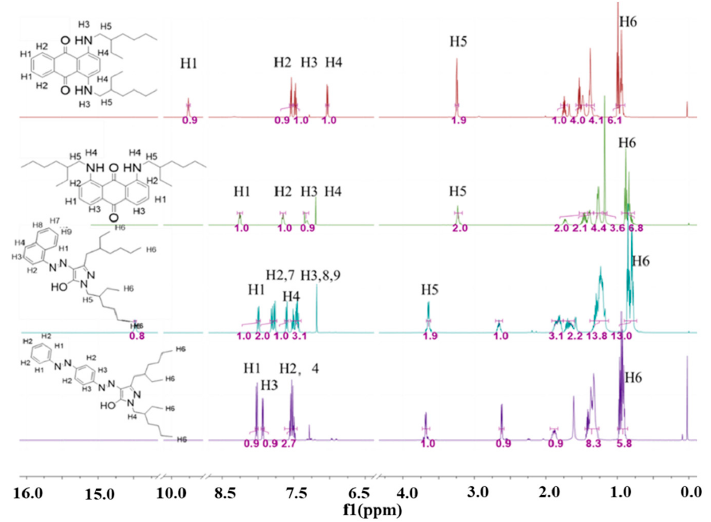
Figure 2. 1 H NMR spectra of four synthesized dyes.